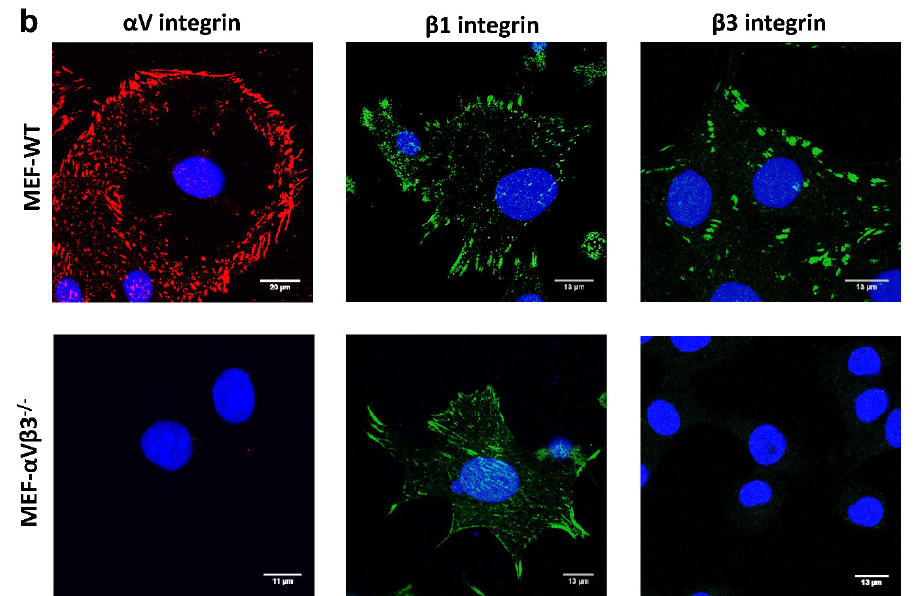
Figure 1. Integrin expression patterns in MEF-WT and MEF- α V β 3 − / − . Cells were analyzed by flow cytometry ( a ) and laser scanning confocal microscopy ( b ). In ( a ), cells were incubated with anti- integrin subunit-specific antibodies followed by incubation with secondary antibodies labelled with Alexa 647 (red histograms) or Alexa 488 (green histograms). Cell controls correspond to untreated cells. Histograms represent the mean fluorescence intensity (MFI; x -axis) and the cell counts ( y -axis). Total cell counts: 1 × 10 4 . In ( b ) cells were cultivated on coverslips and stained with integrin subunit-specific antibodies followed by incubation with secondary antibodies labelled with Alexa 488 (green) or Cy3 (red). Nuclei were stained with DAPI. Laser wavelengths used for imaging: 405 nm (DAPI), 450–470 nm (Alexa 488), 540–570 nm (Cy3). Scale bar: 20 µ m ( α V integrin) and 13 µ m ( β 1 and β 3